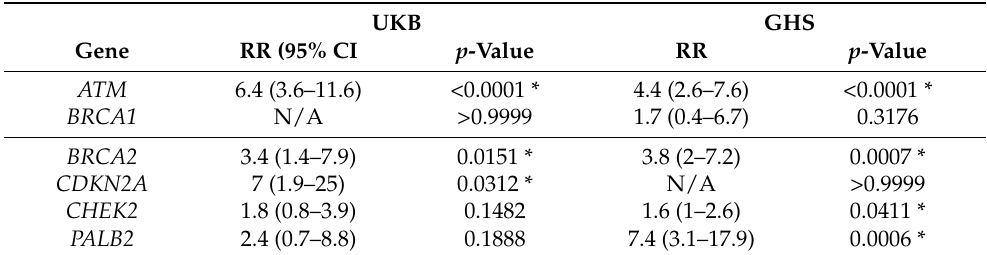
Table 4. The relative risk of pancreatic cancer in participants harboring a germline pathogenic variant for each gene. UKB